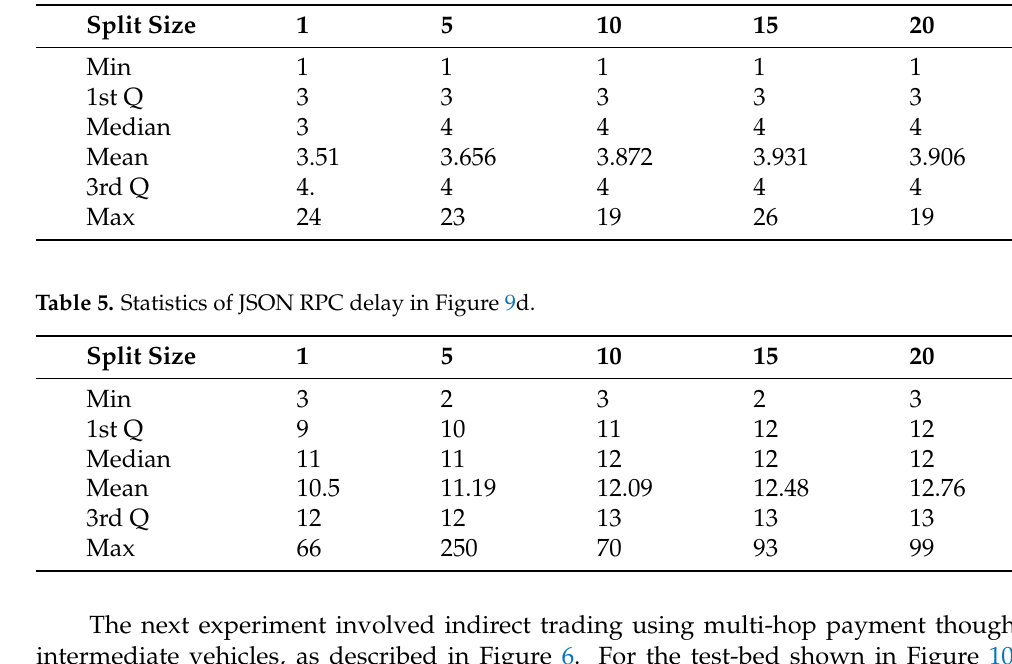
Table 4. Statistics of BP creation delay in Figure 9c.